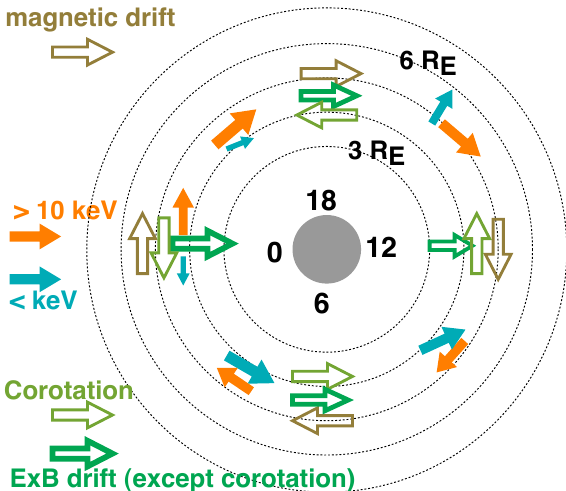
Fig. 1. Illustration of ion drift in the inner magnetosphere. The three major components of the drift (magnetic drift, co-rotation, and E × B drift) are given by the empty arrows, and the resultant ion velocities are given by the solid arrows for high-energy and low- energy components under a moderate magnetospheric condition. The velocity is schematically represented by the size of the arrow. Due to the temporal variation of the electric field, the drift motion of sub-keV ions changes